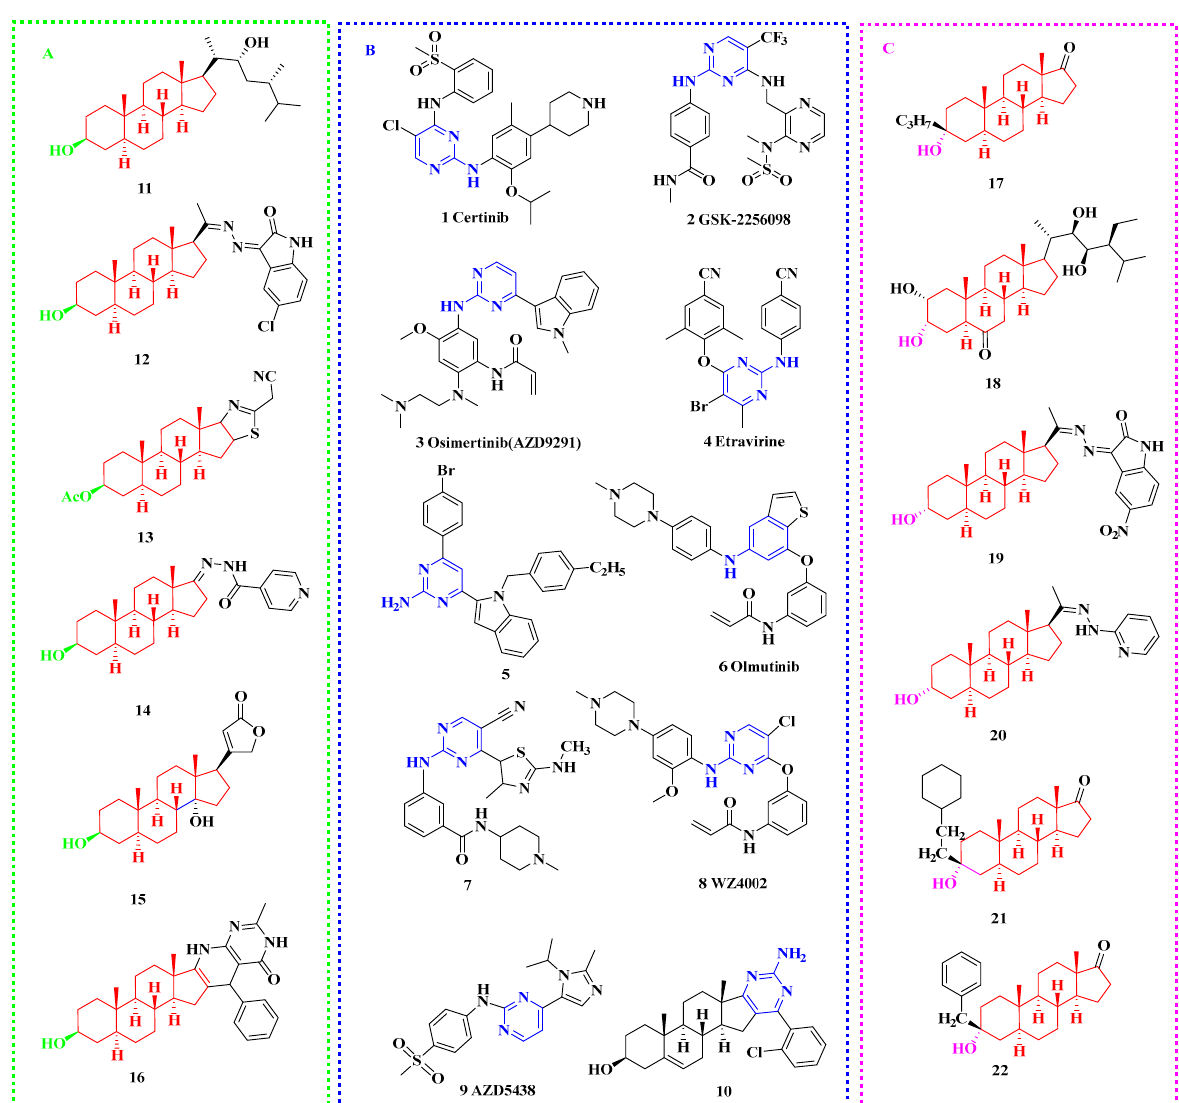
Figure 1. Chemical structures of typical compounds with antiproliferative activity ( A ) epiandros- terone derivatives; ( B ) 2-aminopyrimidine derivatives; ( C ) androsterone derivatives.